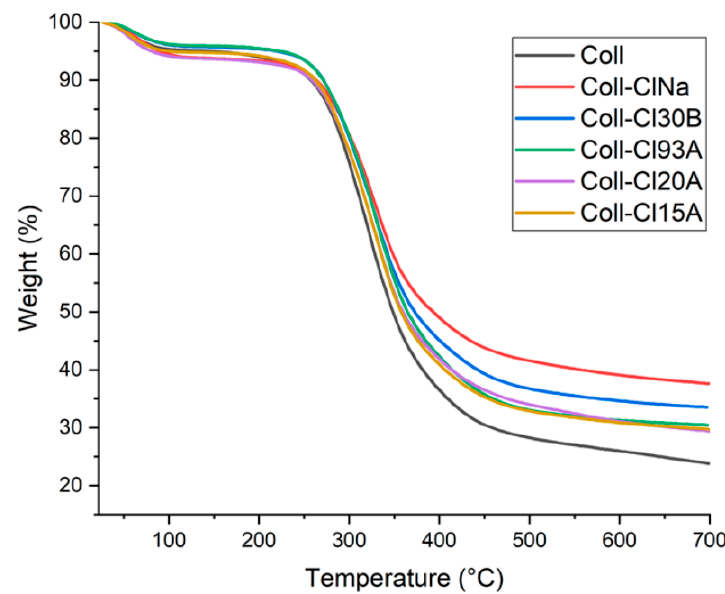
Figure 4. TGA curves of collagen/clay composite biomaterials.